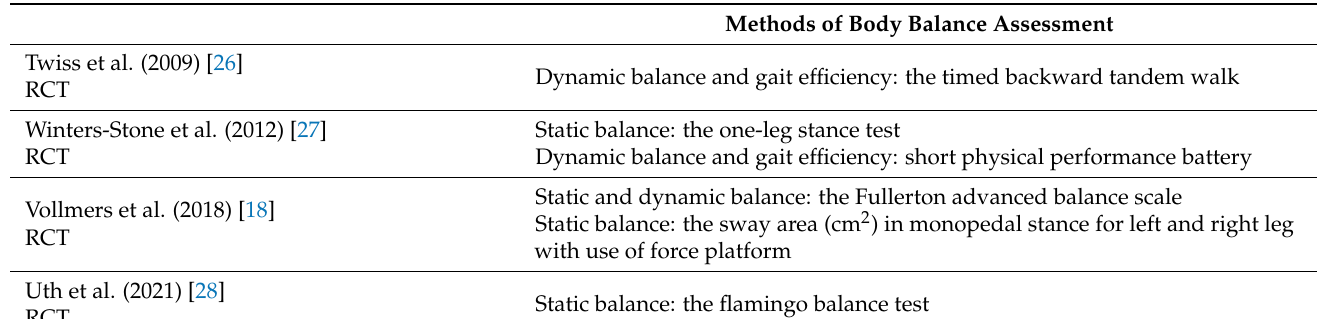
Table 6. Body balance assessment methods in randomized clinical trials and pilot clinical trials. Methods of Body Balance